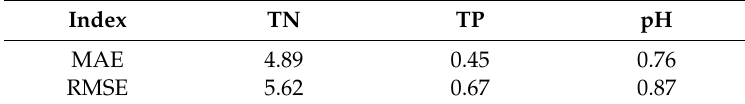
Figure 10. The prediction of pH time series using parallel PSO-LSTM model for 40 moments in time. Table 7. Accuracy of the PSO-LSTM model.